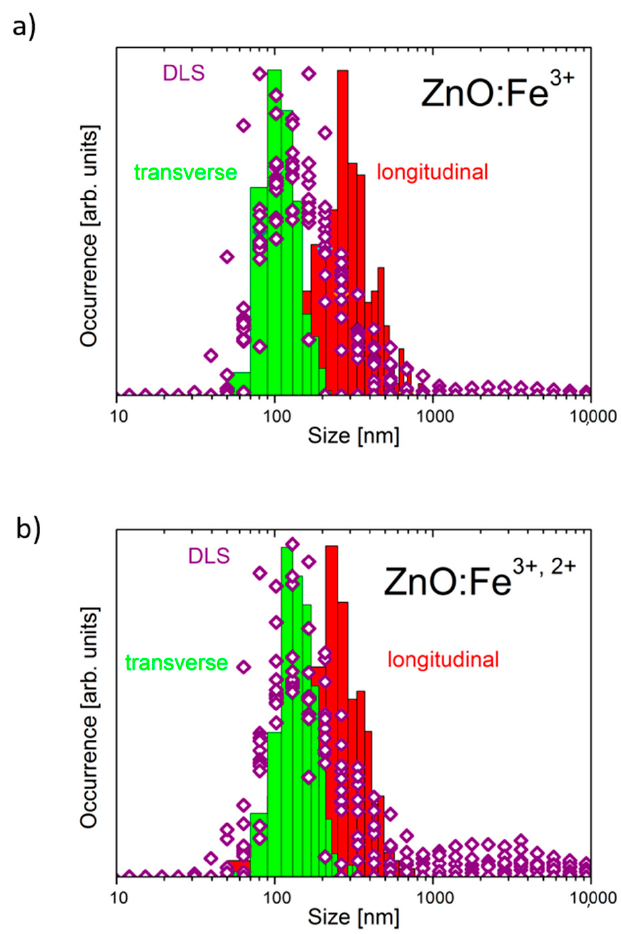
Figure 4. Nanoparticle size distribution as measured using dynamic light scattering (purple diamonds) and scanning electron microscopy techniques (green and red bars, respectively for transverse and longitudinal measurements). ( a ) ZnO:Fe 3+ , ( b ) ZnO:Fe 3+,2+ .